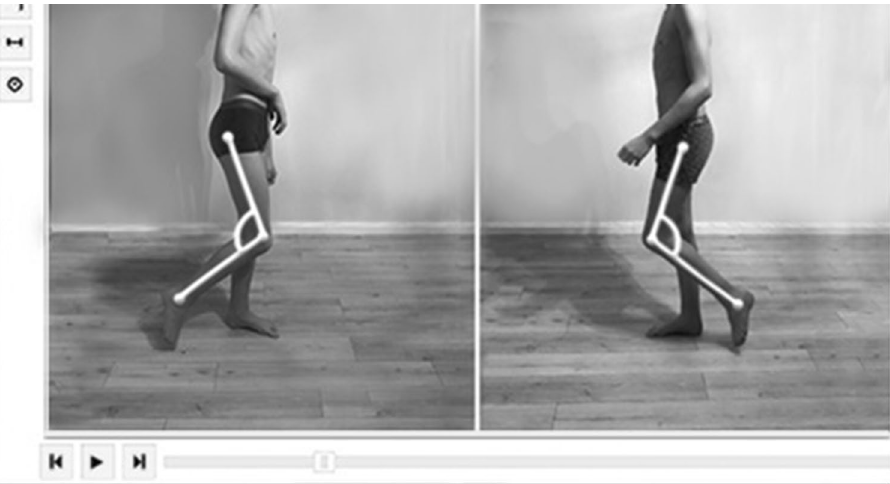
Figure 1. Screenshots of gait videos from the application software for computerised paediatric version of Wisconsin Gait Scale in child with right sided spastic hemiplegic cerebral palsy. The pictures show gait swing phase affected leg, knee flexion from toe off to mid swing. Two straight auxiliary lines are drawn on a freeze frame presenting a side view; these are located along the shank (head of the fibula and lateral malleolus) and along the thigh (trochanter of the femur and lateral condyle of femur). The angle created by these two lines is measured, and compared to the result identified for the unaffected leg. The rater examines the values of the angles, and determines the rating in the following way: affected knee flexes as much as the unaffected knee; affected knee flexes less than the unaffected knee; affected knee flexes more than the unaffected knee; minimal